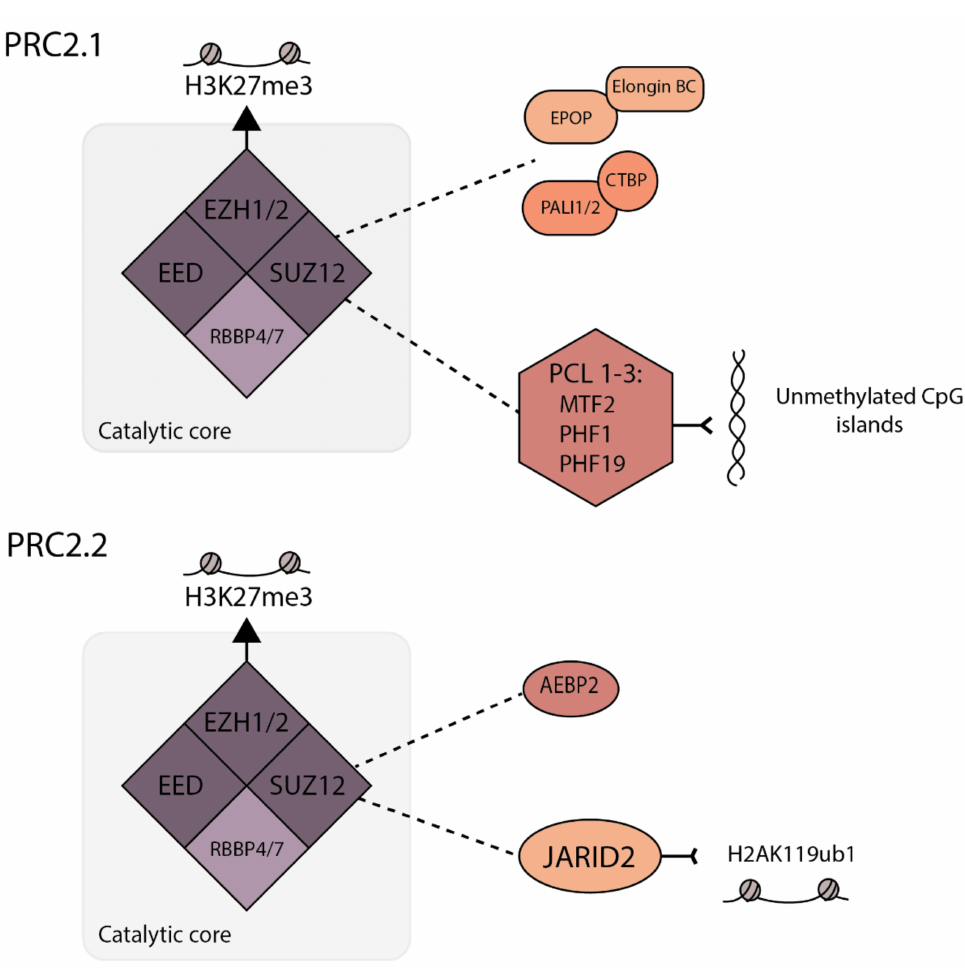
Figure 1. The composition of PRC2.1 and PRC2.2 complexes. Polycomb repressive complex 2 (PRC2) has a catalytic core of EED, EZH1/2 and SUZ12 along with RBBP4/7. PRC2 carries out all three methylation states of H3K27, but H3K27me3 is the only one stably bound by the complex. To form the PRC2.1 complex, the core can interact with either PALI1/2 and CTBP or EPOP and Elongin BC. One pair excludes the other from joining the complex. SUZ12 in PRC2.1 also interacts with one of three PCL proteins, but this interaction does not compete for the aforementioned interacting pairs. PCL proteins enable binding to unmethylated CpG islands. PRC2.2 forms by SUZ12 in the same catalytic core interacting with JARID2 and AEBP2. Unlike PRC2.1, JARID2 enables PRC2.2 recruitment to sites of